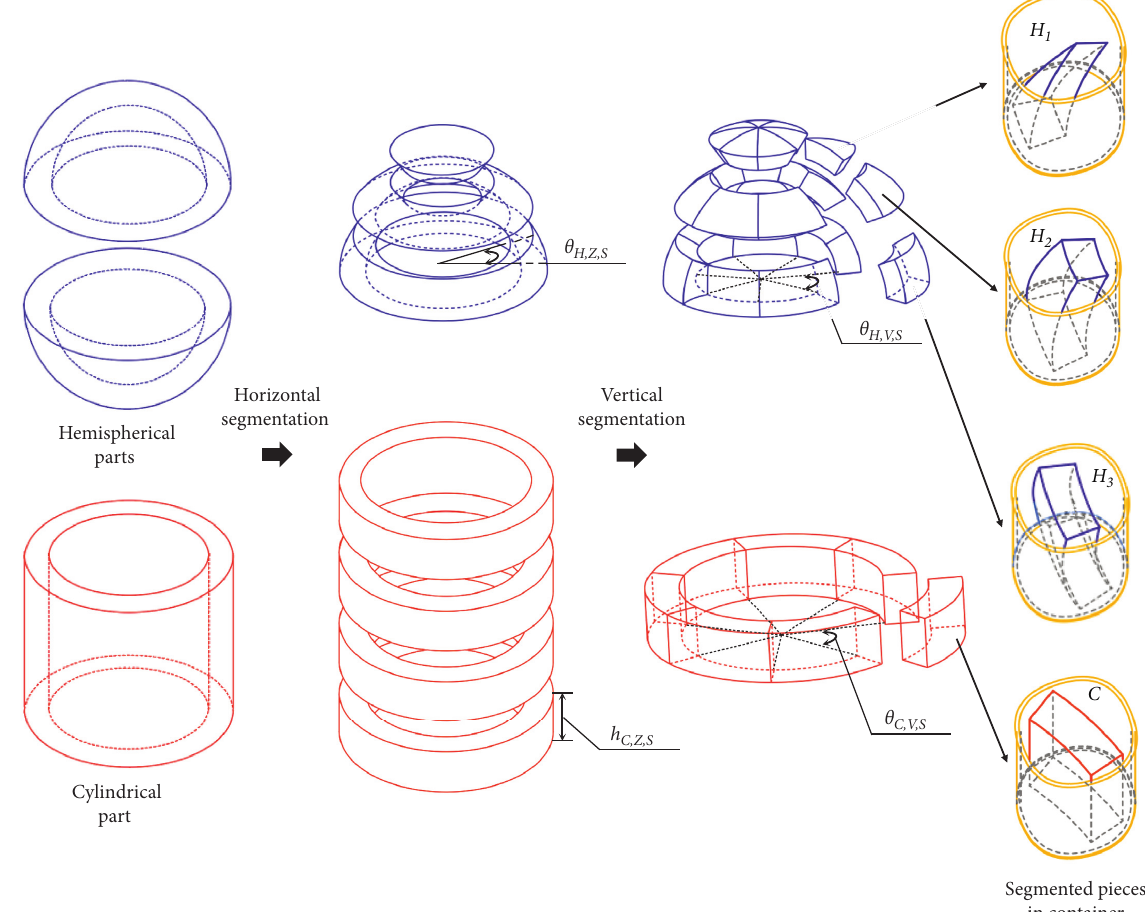
Figure 3: Schematic view of sequential segmentation strategy for the spherocylinder-type object shown in Figure 1(a).